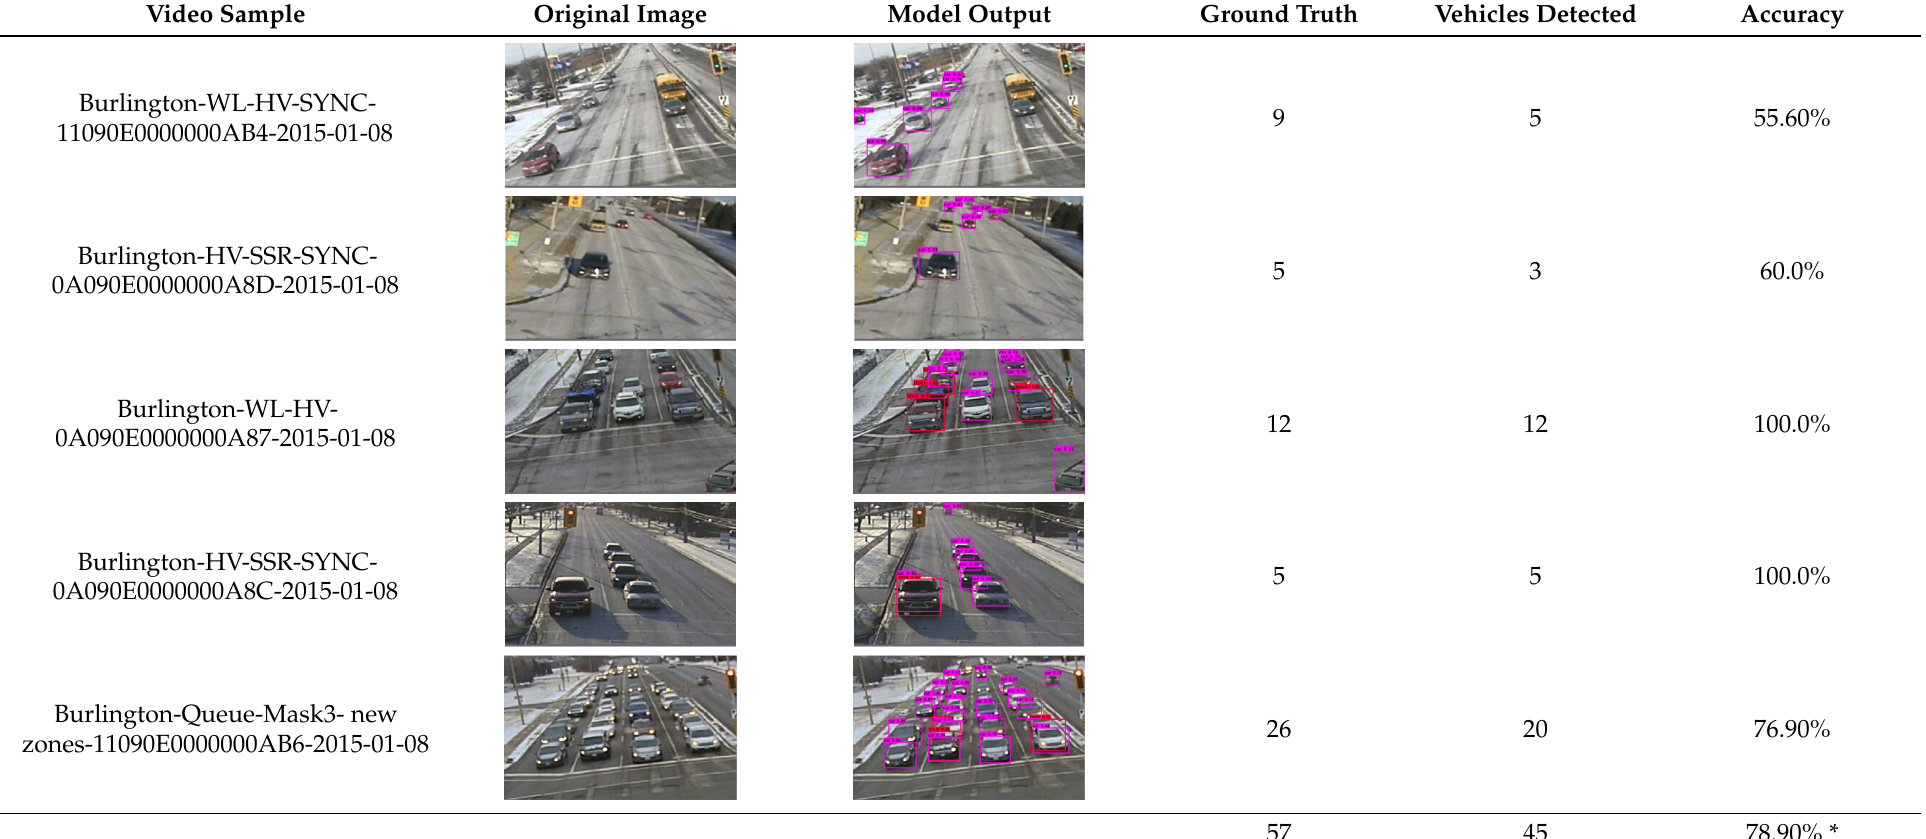
Table A3. Vehicle detection accuracies on selected images obtained from Burlington video using YOLOv3. Cars and trucks marked as purple and red colors